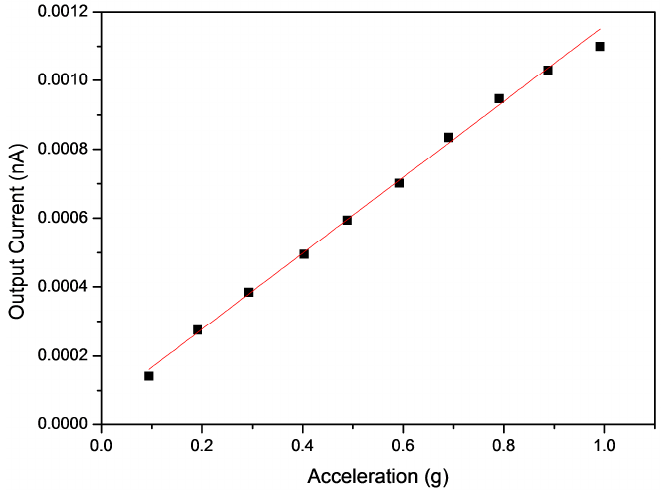
Figure 9. Output current of the fabricated accelerometer and the acceleration of the commercial accelerometer at 100 Hz.